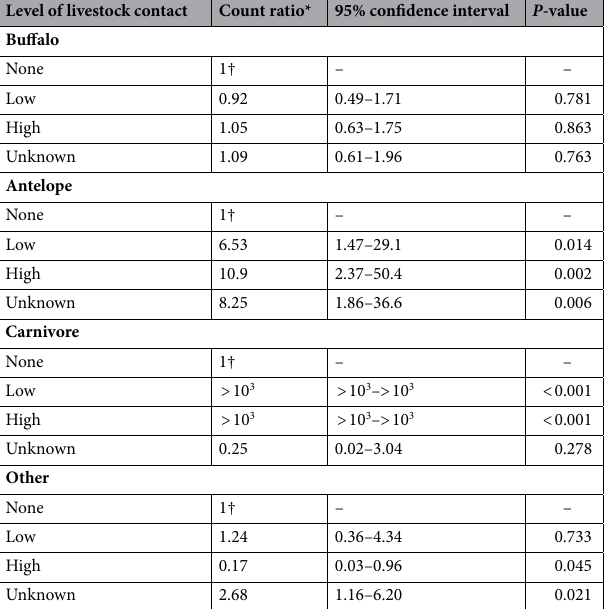
Table 7. Association between degree of livestock contact and seroprevalence to Brucella in different wildlife species categories, obtained from the count model presented in Table 6. *Ratio of seroprevalence vs. reference category, within infected population. † Reference